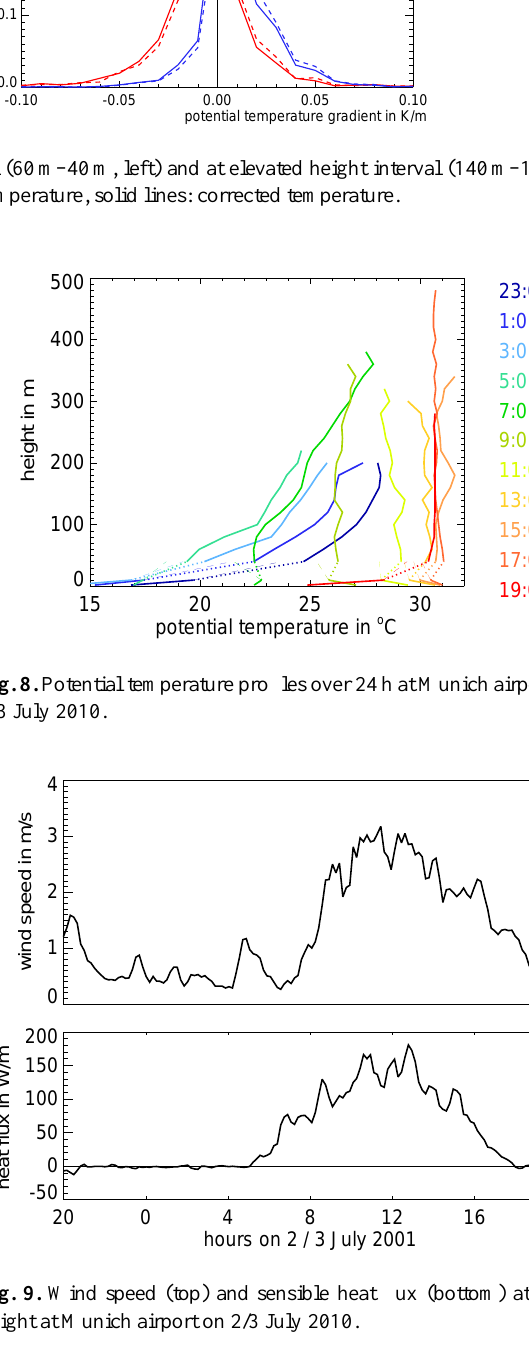
Fig. 9. Wind speed (top) and sensible heat flux (bottom) at 10m Figure9:Windspeed(top)andsensibleheat(cid:29)ux(bottom)at10mheightatMuni hairporton2/3July2010. height at Munich airport on 2/3 July